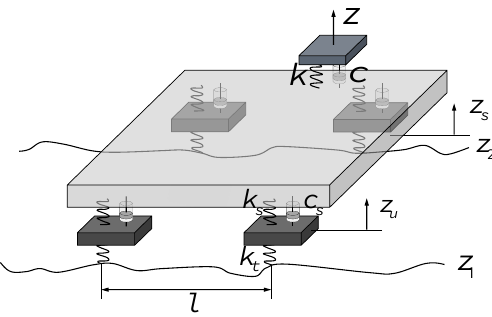
Figure 2. Full-car model.